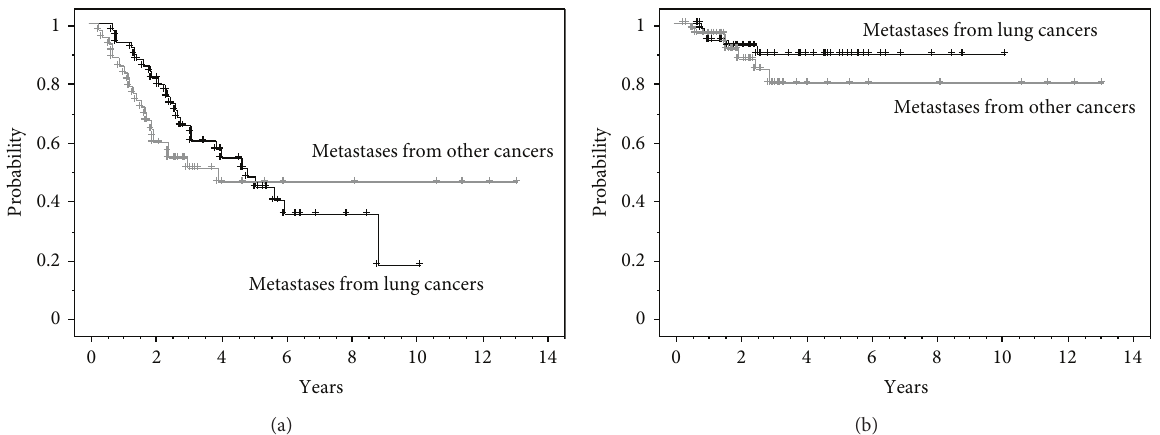
Figure2:(a)Overallsurvivalforlungmetastasesfromlungcancer( 𝑛 = 49 )versusothercancer( 𝑛 = 42 ).(b)Localcontrolforlungmetastases from lung cancers ( 𝑛 = 58 ) versus other cancers ( 𝑛 = 58